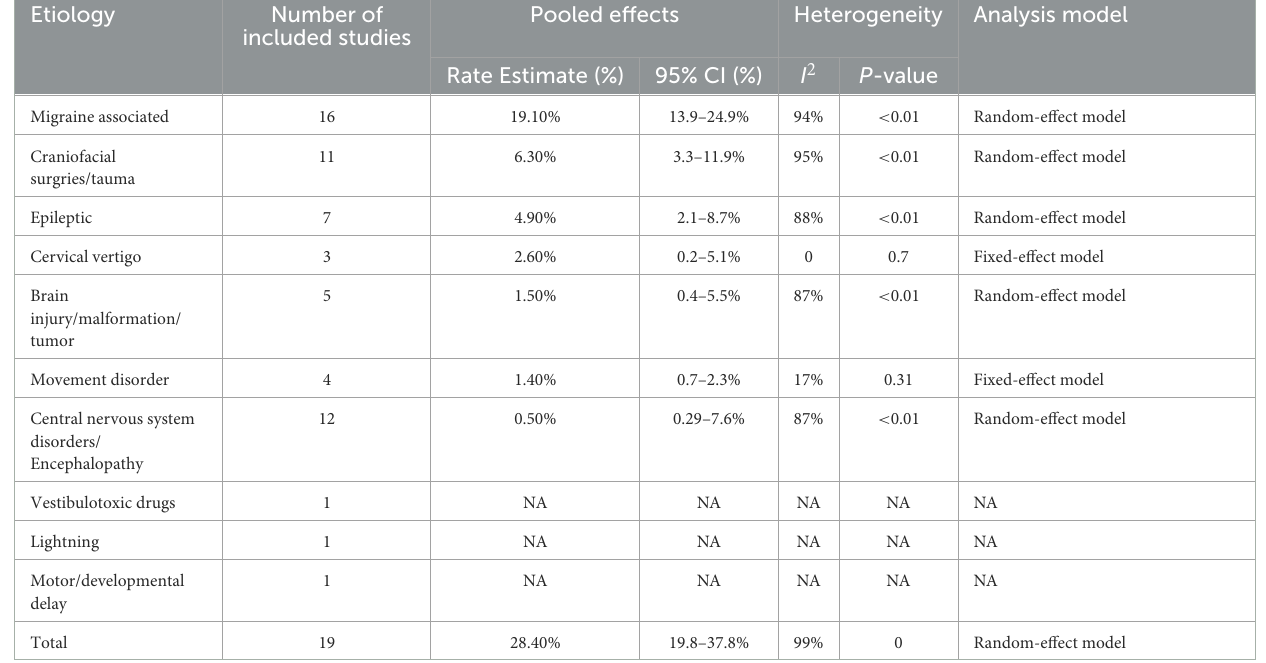
TABLE 4 Pooled analysis of each etiology for central